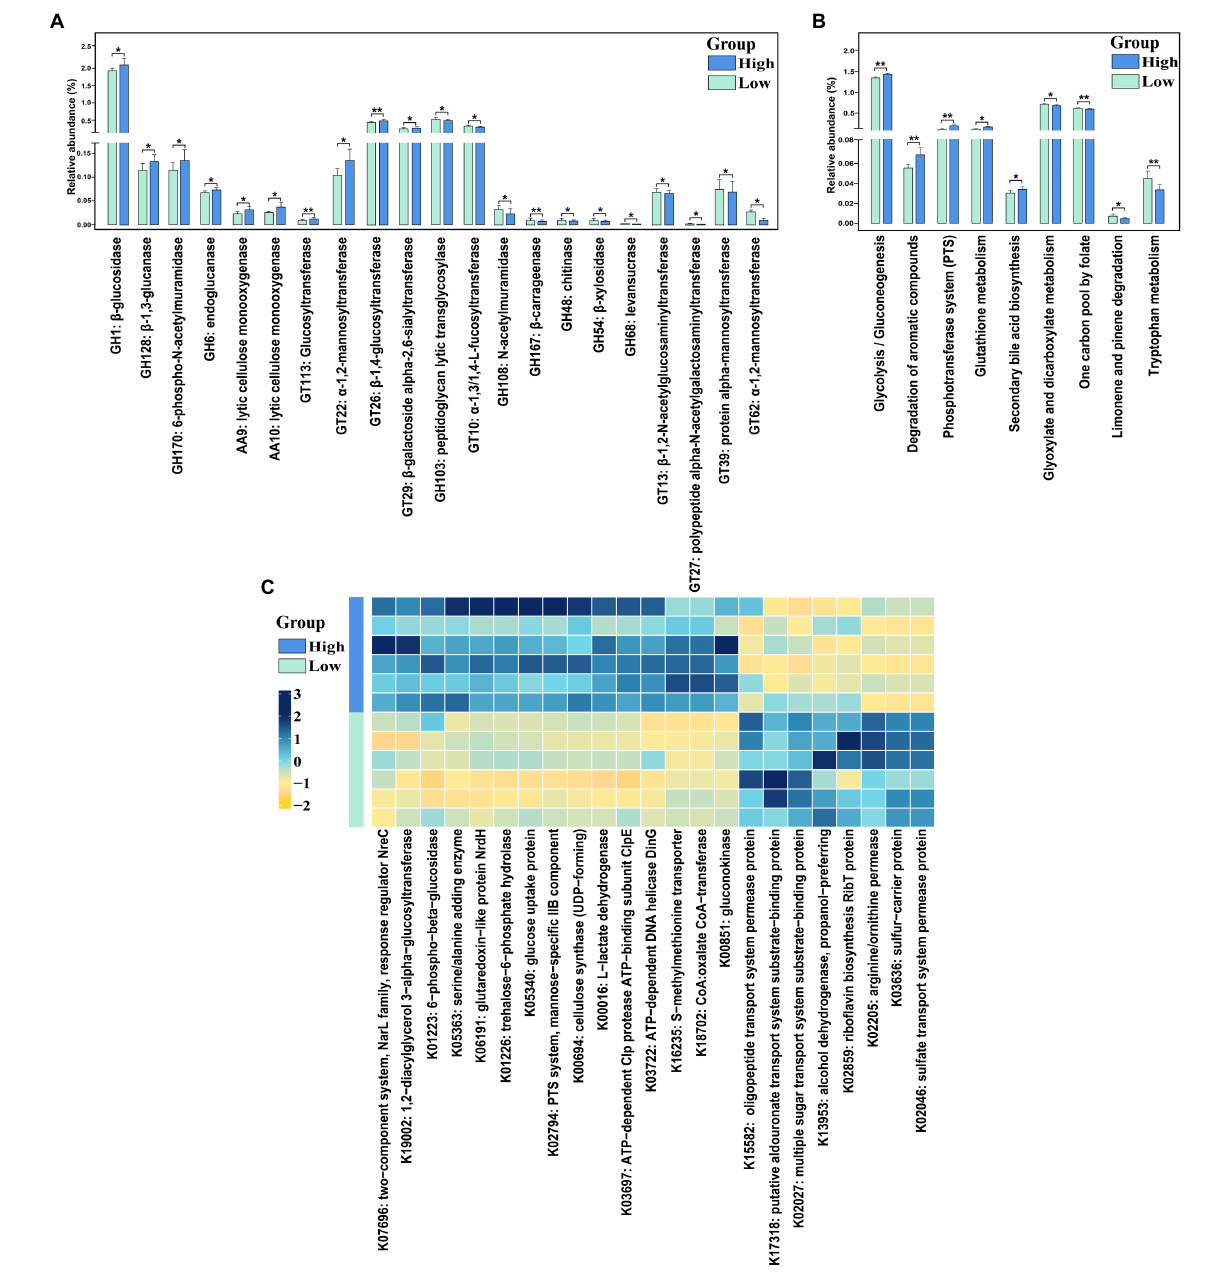
FIGURE 5 The CAzymes and KEGG function terms exhibiting different enrichments between low and high finishing weight pigs. (A) The differential CAzymes are detected to relate with finishing weight. (B) The differential KEGG pathways are identified to associate with finishing weight. (C) Heat map of KOs displaying different enrichments between low and high finishing weight pigs. “*” and “**” represents for FDR adjusted p < 0.05 and p < 0.01, respectively. The rectangles with green and blue colors represent low and high finishing weight groups,